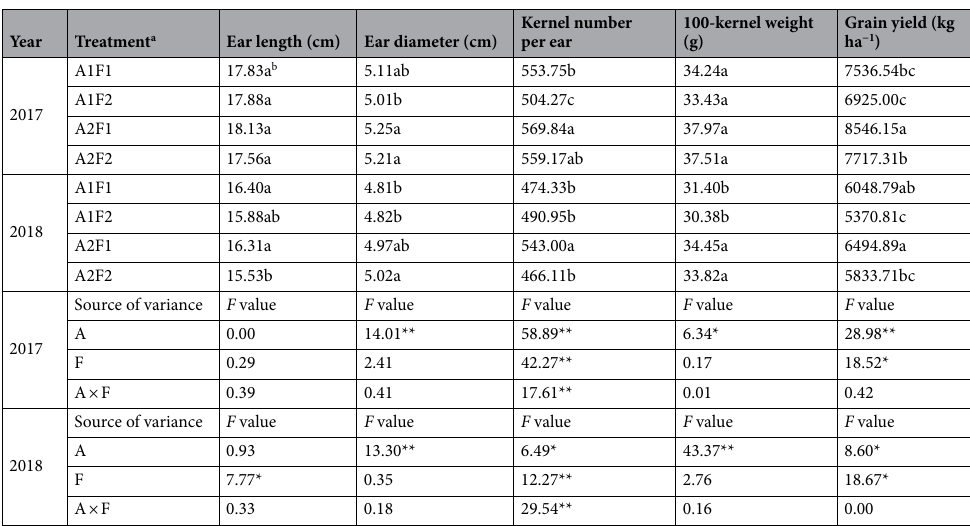
Table 4. The grain yield and yield components of summer maize under different treatments in 2017 and 2018. a A and F represent dripline spacing and fertilization rate, respectively, as shown in Fig. 2 and Table 2. b Values within a column followed by different letters are significantly different at the 0.05 probability level; * and ** show significant difference at the 0.05 and 0.01 probability levels,